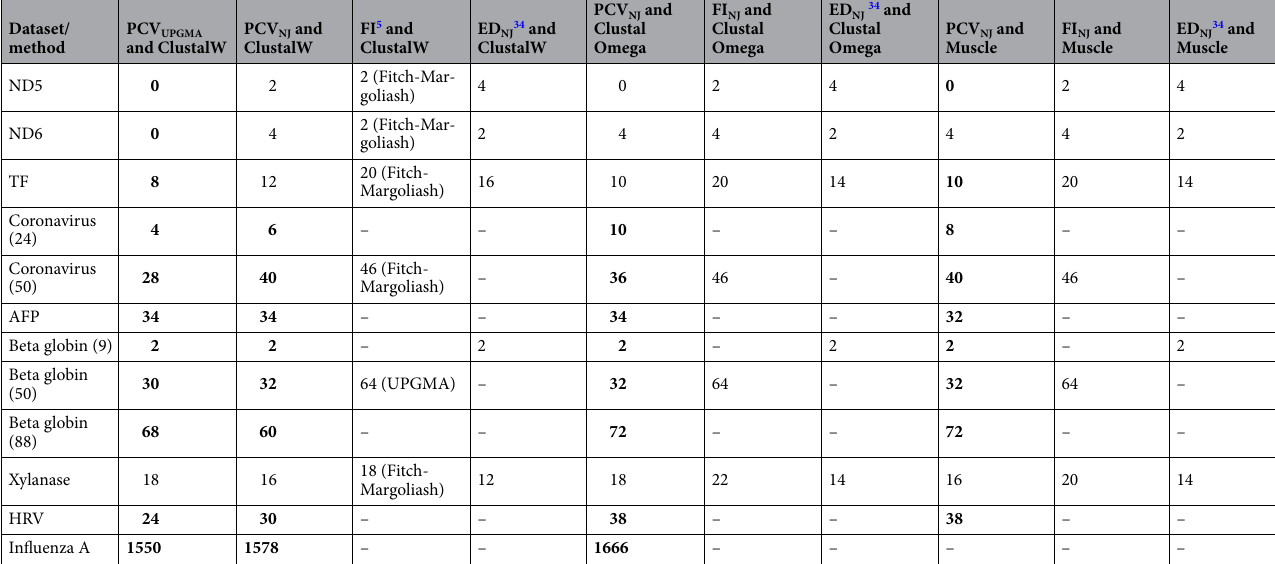
Table 3. Comparison of PCV (both UPGMA and NJ trees), ED and Fuzzy integral based method based on Robinson Foulds (RF) distance for 12 benchmark datasets. Significant values are in bold.